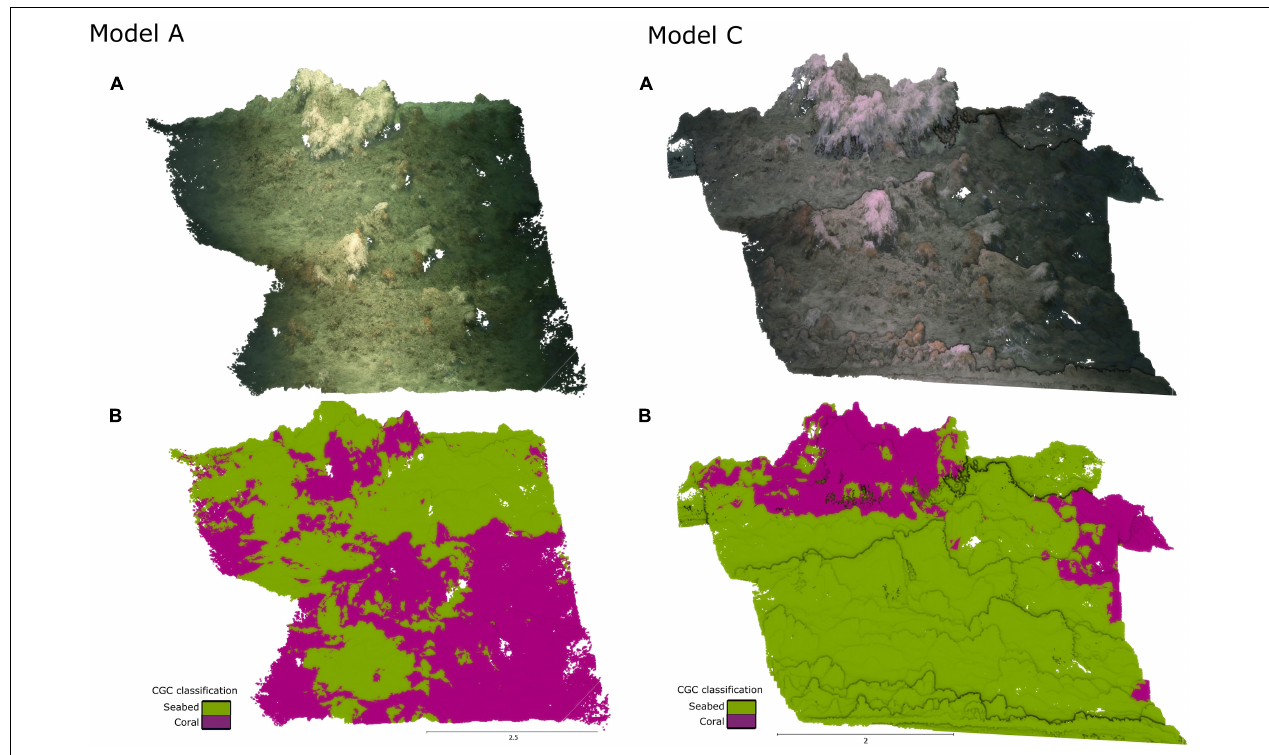
FIGURE 7 | Results of classification using CGC method— (A) Dense cloud and (B) classification output with CGC